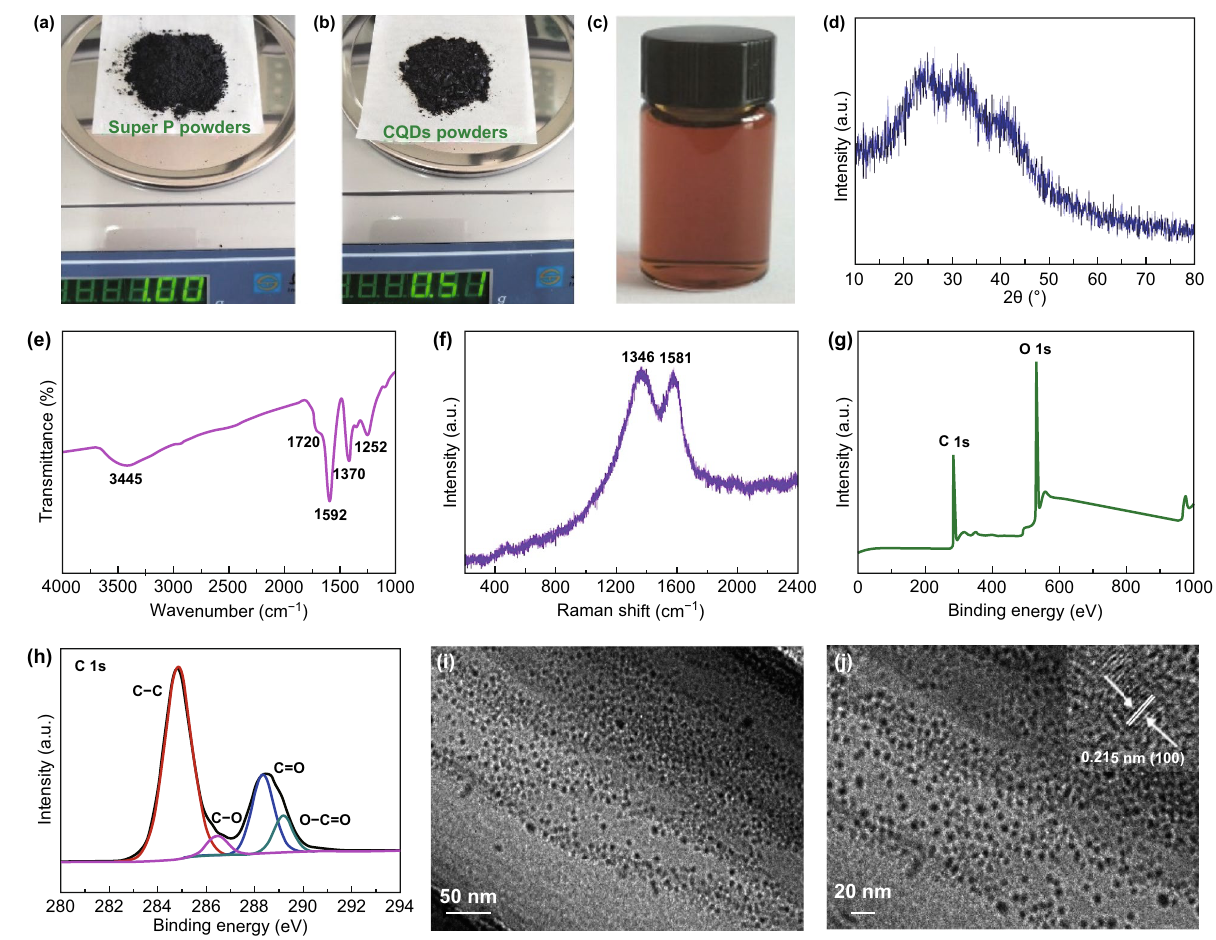
Fig. 2 Digital photograph of a Super P powders, b CQDs powders, and c CQDs aqueous solution with a concentration of 1 mg mL −1 . d XRD pattern, e FTIR spectroscopy, f Raman spectroscopy, g XPS survey spectrum, h high‑resolution C 1 s spectrum, i , j TEM images and HRTEM image (inset of Fig. 2j) of